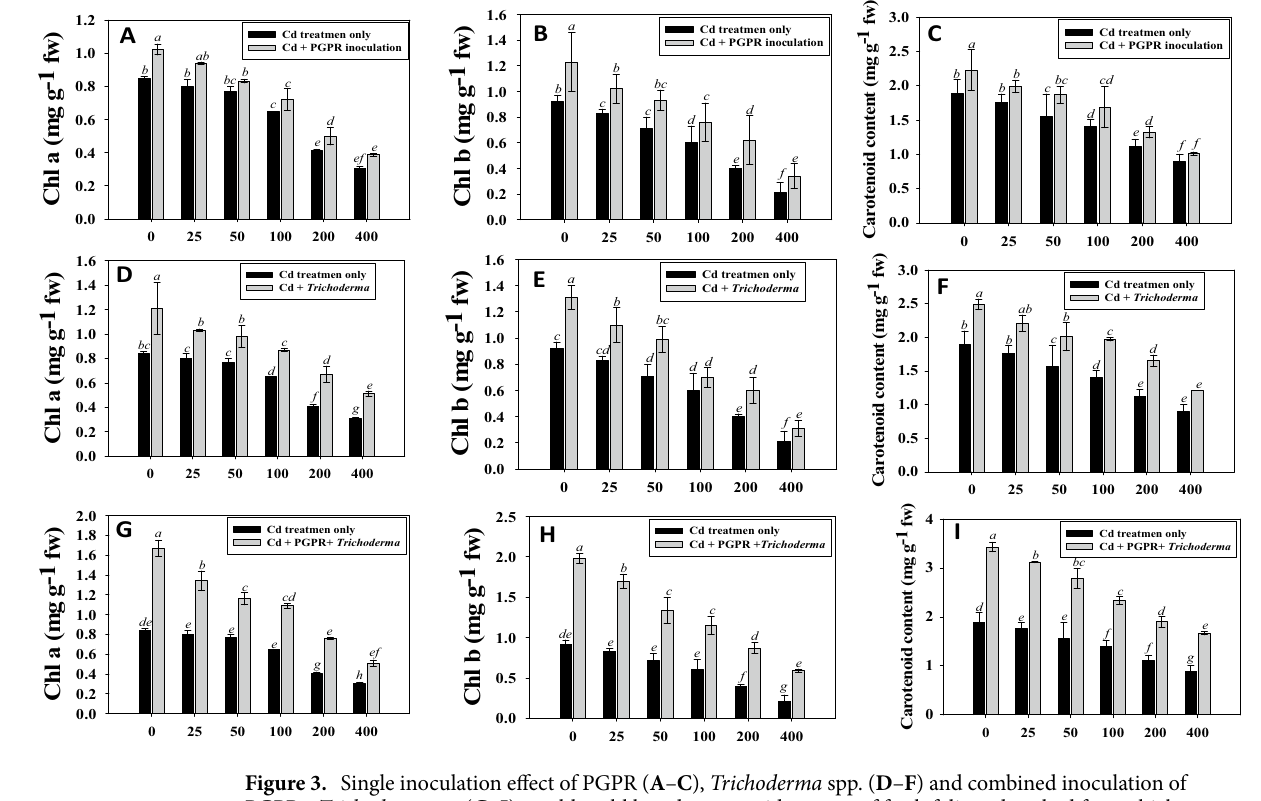
Figure 3. Single inoculation effect of PGPR ( A – C ), Trichoderma spp. ( D – F ) and combined inoculation of PGPR + Trichoderma sp. ( G – I ) on chl a, chl b and carotenoid content of fresh foliage detached from chickpea plants raised in soil affected with 0, 25, 50, 100, 200 and 400 μgCdmL −1 . Each bar diagram represents the mean of three replicates ( n = 3). Corresponding error bars represent standard deviation (S.D.) of replicates. Different letters represent that mean values are significantly different according to DMRT